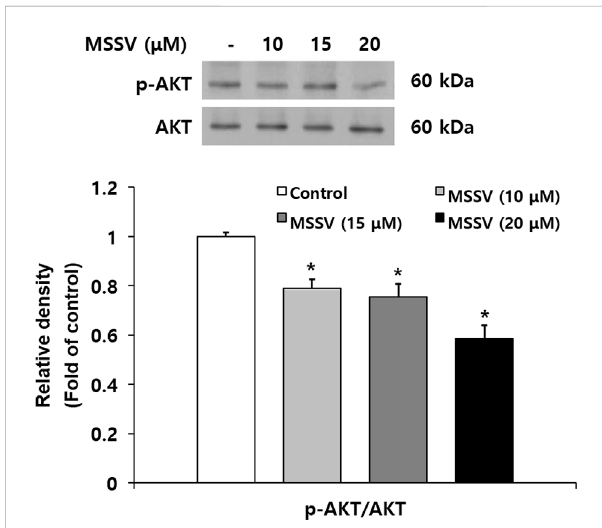
FIGURE 5 MSSV inhibited the phosphorylation of AKT in HCT116 cells. Cells were treated with MSSV at concentrations of 10, 15, and 20 μ M for 24 h.ThephosphorylationofAKTincellstreatedwithMSSVrevealeda statistically signi fi cant reduction in comparison to the control group. The bar represents the relative fold changes in proteins at different concentrations of MSSV in comparison with the control group.Dataarepresentedasmean±SDandthe*(asterisk)indicatesa statistically signi fi cant difference. A p -value of < 0.05 was considered statistically signi fi